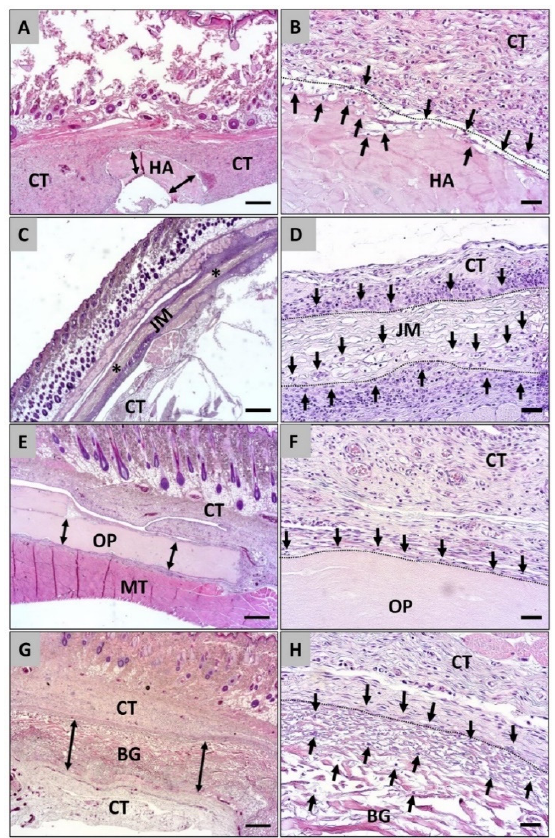
Figure 2. Histological images of the integration behavior and the tissue reactions of the four different collagen membranes implanted into the subcutaneous connective tissue (CT) at day 10 post implantationem. Left column: All four membranes ( A , E , G = double arrows, C = asterisks) were detectable within their implantation beds without signs of fragmentation or material breakdown (H&E staining, 100 × magnification, scalebar = 200 µ m). Right column ( B , D , F , H ): Different cellu- lar migration patterns (black arrows) were observed starting from the material surfaces (dashed lines). HA = hyaluronan/collagen membrane, JM = Jason ® membrane, OP = Ossix ® Plus membrane, BG = Bio-Gide ® membrane (H&E staining, 200 × magnification, scalebar = 20 µ